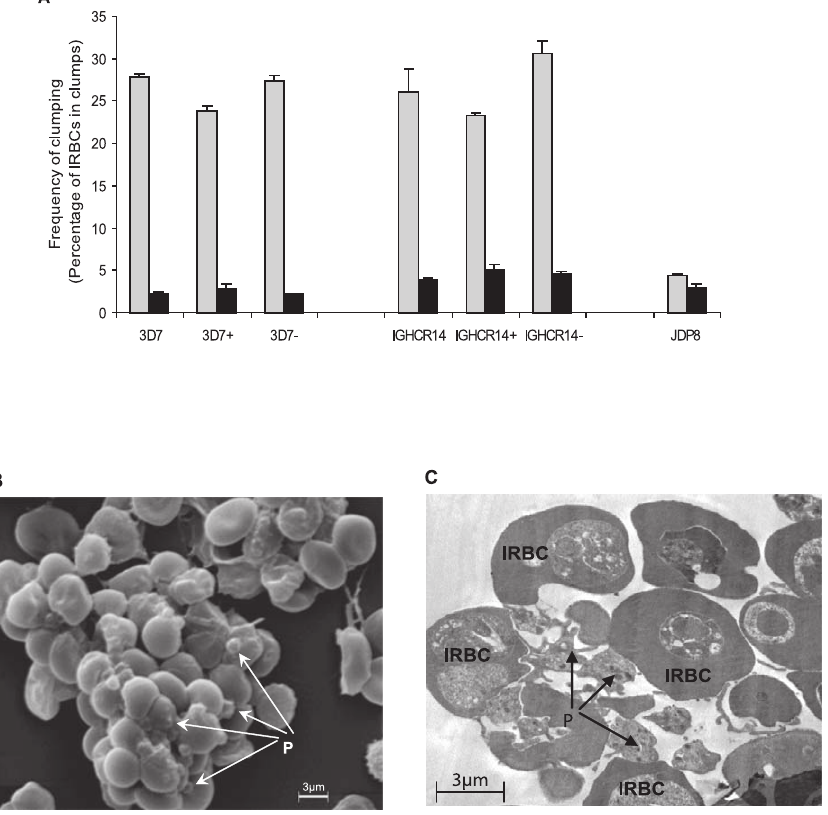
Figure 3. Platelet-Mediated Clumping of P. falciparum IRBCs (A) Frequency of platelet-mediated clumping in PRP and PPP. P. falciparum field isolate IGH-CR14, laboratory strain 3D7, and their derivatives, IGH- CR14 þ and 3D7 þ , which bind gC1qR/HABP1, IGH-CR14 (cid:2) , and 3D7 (cid:2) , which bind CD36, and P. falciparum isolate JDP8, which does not bind gC1qR/ HABP1 or CD36, were tested for clumping in the presence of PRP and PPP. Parasites in trophozoite and schizont stages were allowed to form clumps in the presence of PRP and PPP. Parasites were stained with acridine orange and the clumping frequency was determined by scoring the frequency of IRBCs found in clumps. Approximately 500 IRBCs were scored for each parasite. The frequency of clumping in the presence of PRP (grey bars) and PPP (black bars) is shown. (B) Scanning electron micrograph of platelet-mediated clumps formed by IGH-CR14 þ . Clumps formed by IGH-CR14 þ IRBCs in the presence of PRP were analyzed by scanning electron microscopy. Electron micrograph shows several platelets (marked P), which bridge IRBCs in the clumps. (C) Transmission electron micrograph of platelet-mediated clumps formed by IGH-CR14 þ . Clumps formed by IGH-CR14 þ IRBCs in the presence of PRP were analyzed by transmission electron microscopy. Only IRBCs are present in the clumps. The IRBCs are closely associated with platelets (P) in